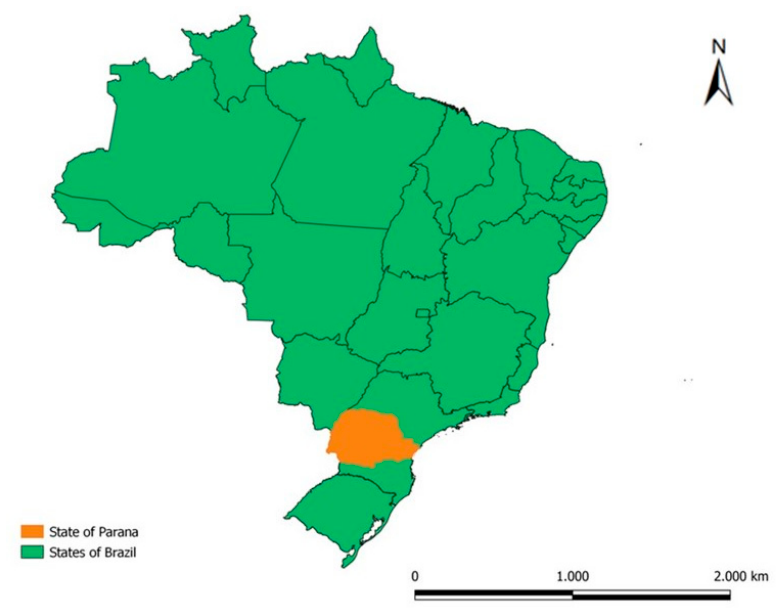
Figure 1. Geographic location of the state of Paraná in Brazil. Legend: ArcGIS [GIS software]. Version 10.0. Redlands, CA, USA, EUA: Environmental Systems Research Institute, Inc., 2010.